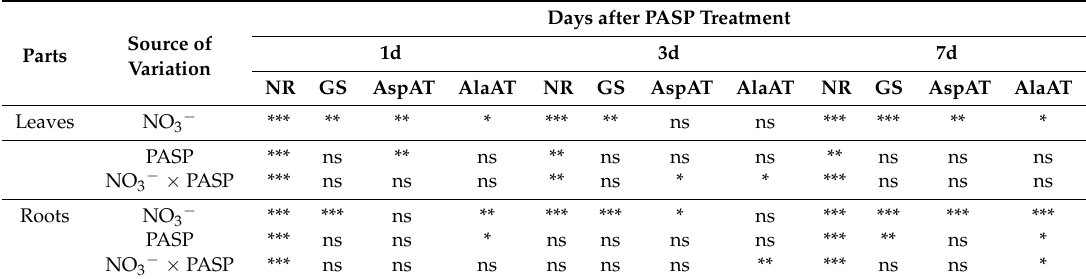
Table 2. Multiple analyses of enzyme activities correlated to nitrogen metabolism in maize seedlings leaves and roots at the 1st, 3rd, and 7th day after PASP treatment.